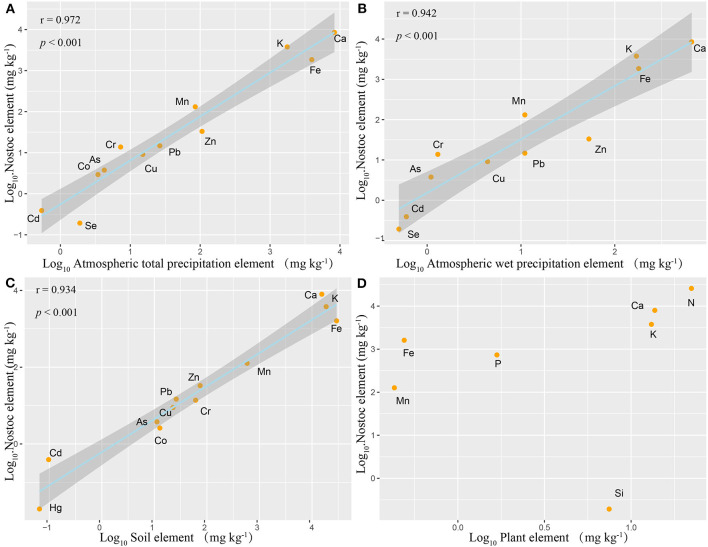
Relationships between mean N. commune and plant leaf mineral concentration and atmospheric deposition and soil mineral concentration. (A) Nostoc vs. Atmospheric total deposition, Log10(y) = 1.069 Log10(x)−0.258 (r2 = 0.972, p < 0.001); (B) Nostoc vs. Atmospheric wet deposition, Log10(y) = 0.669 Log10(x)−0.007 (r2 = 0.942, p < 0.001); (C) Nostoc vs. Soil, Log10(y) = 0.861 Log10(x)−0.213 (r2 = 0.934, p < 0.001); (D) Nostoc vs. Plant leaf. Ninety fine percentage of confidence bands for all fitted curves are also shown.